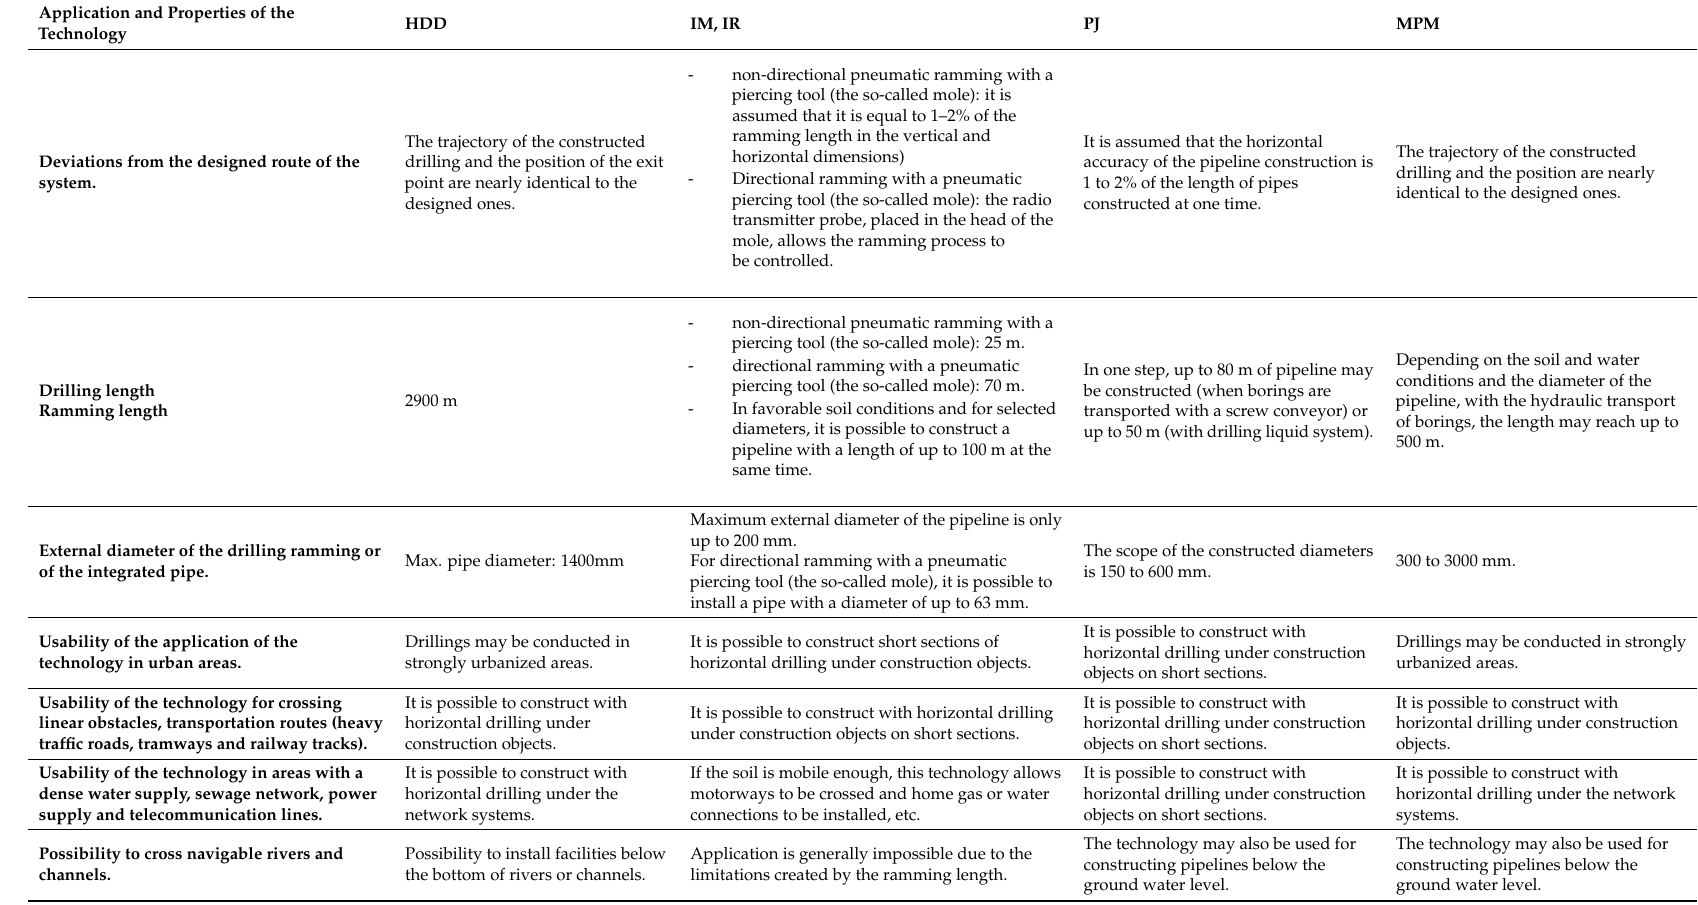
Table 3. Comparison of Trenchless methods of building a technical infrastructure